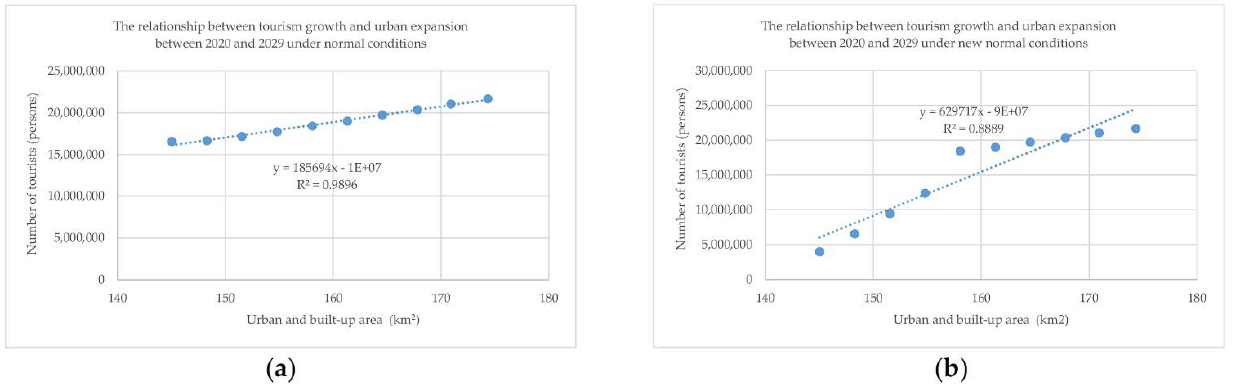
Figure 14. Simple linear regression analysis between tourism growth and urban expansion in Phuket Island between 2020 and 2029: ( a ) normal condition; ( b ) new normal condition (COVID-19 pandemic).